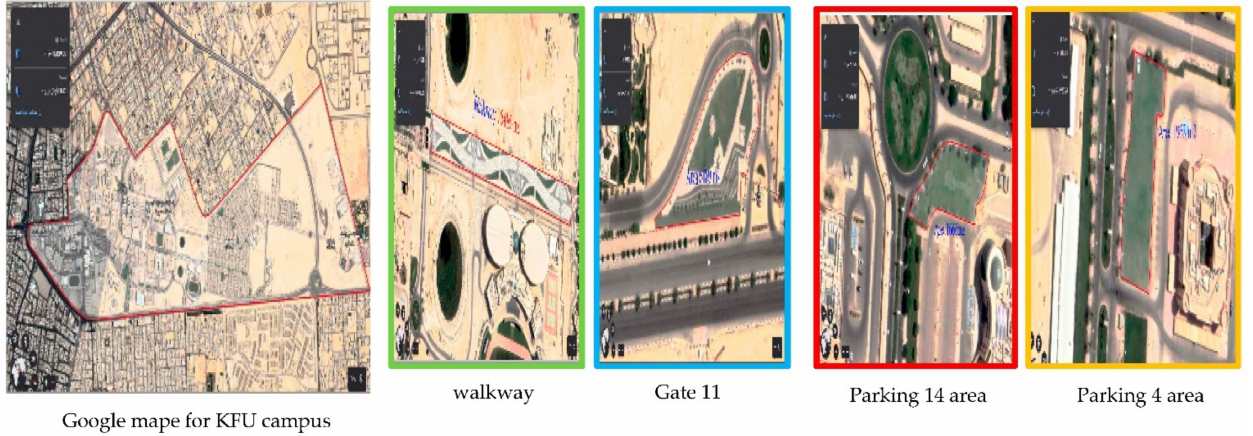
Figure 4. King Faisal University general location and applied case study areas